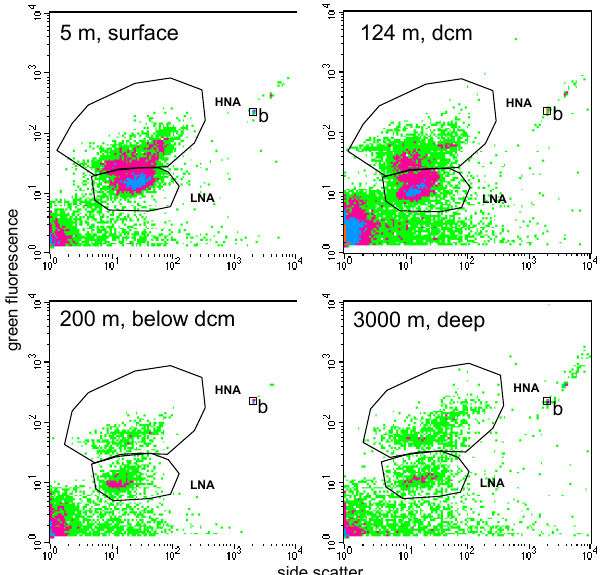
Fig. 2. Examples of four cytograms obtained after SyBR green I staining. The data comes from Station B (Ionian Sea): surface (5m), at the dcm (125m), below dcm (200m) and in deep layers (3000m). Time of analysis was set to 1min for the 3 first layers, and 3min for the 3000m layer. Windows for HNA and LNA cells are drawn and were adjusted from one sample to another. b: 1µm